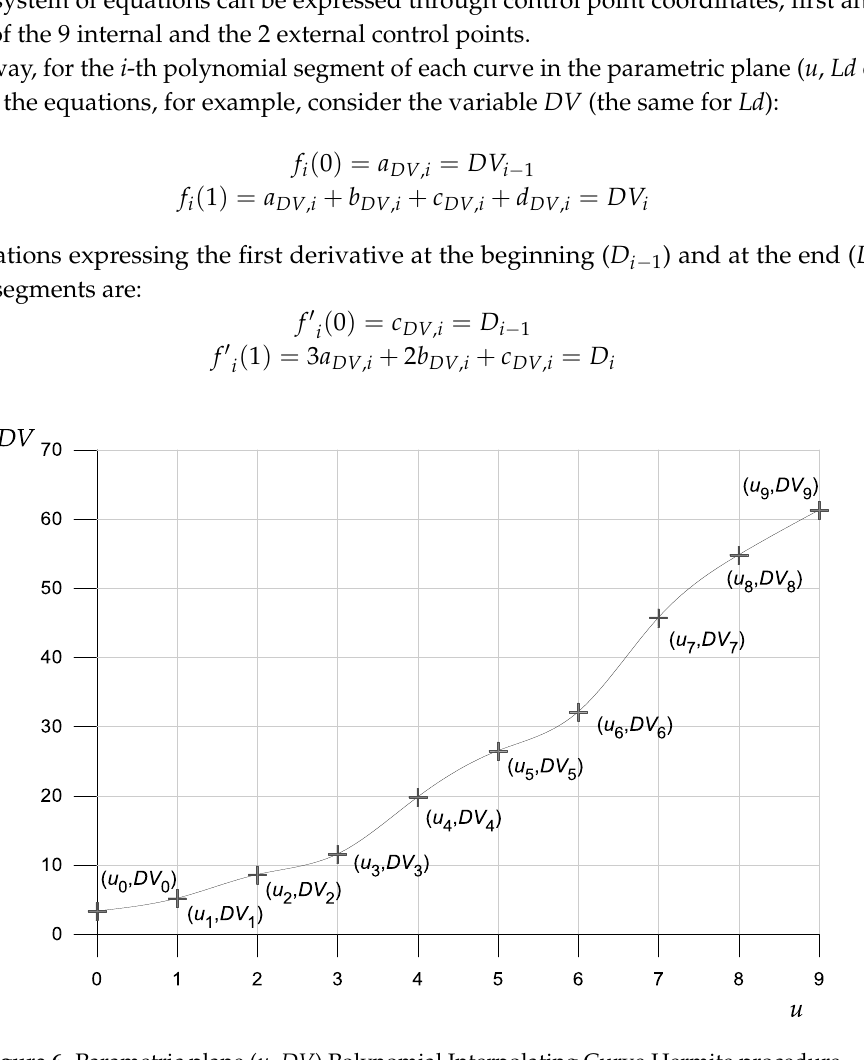
Figure 6. Parametric plane ( u , DV ) Polynomial Interpolating Curve Hermite procedure.